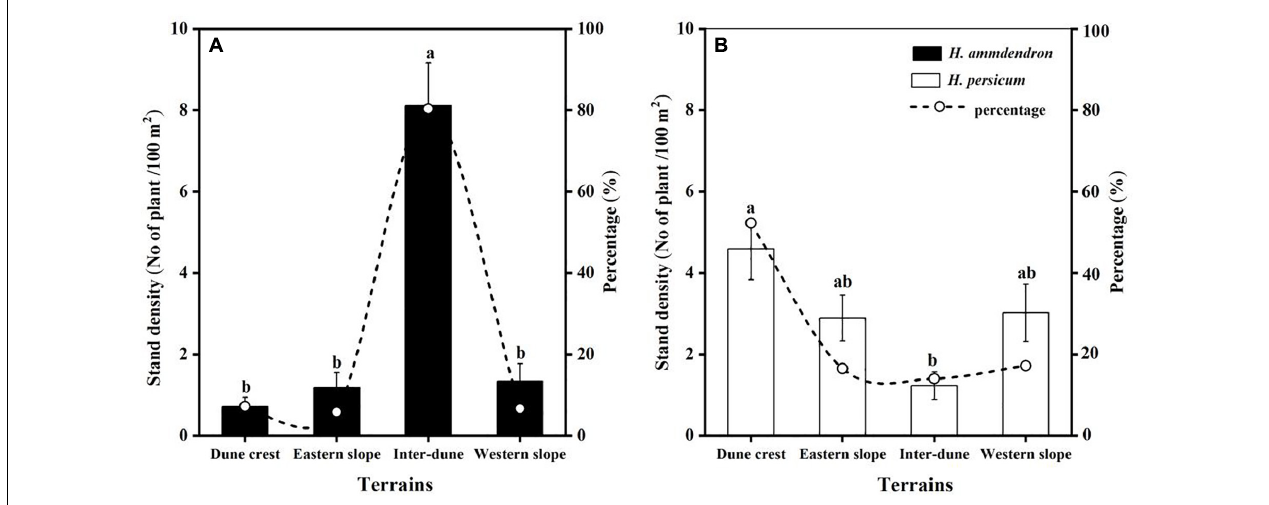
FIGURE 3 | Quantitative characteristic of Haloxylon ammodendron (A) and H. persicum (B) at different terrains. Different letters represent significant differences ( p < 0.05). Data are presented as the mean ± 1 standard error.